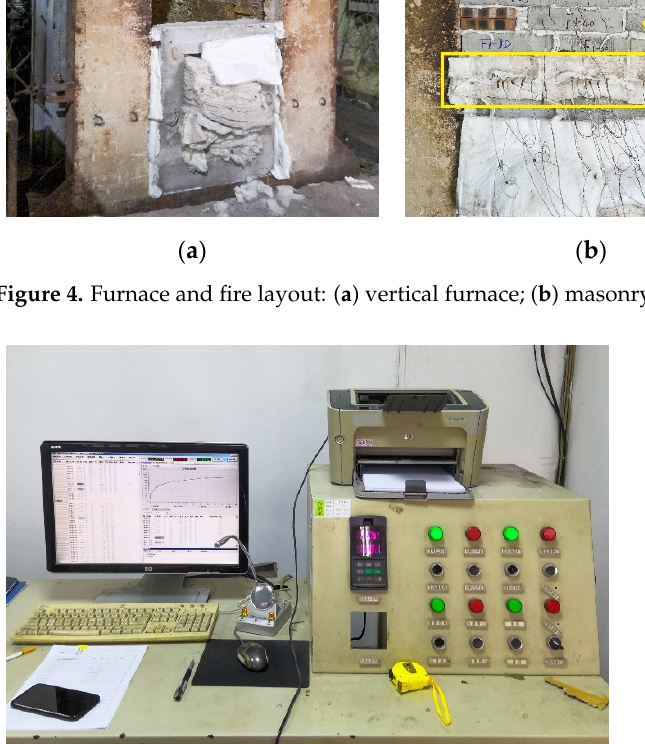
Figure 4. Furnace and fire layout: ( a ) vertical furnace; ( b ) masonry effect of the specimen. According to a decade of statistics, about 70% of urban fires burn within 60 min [52].